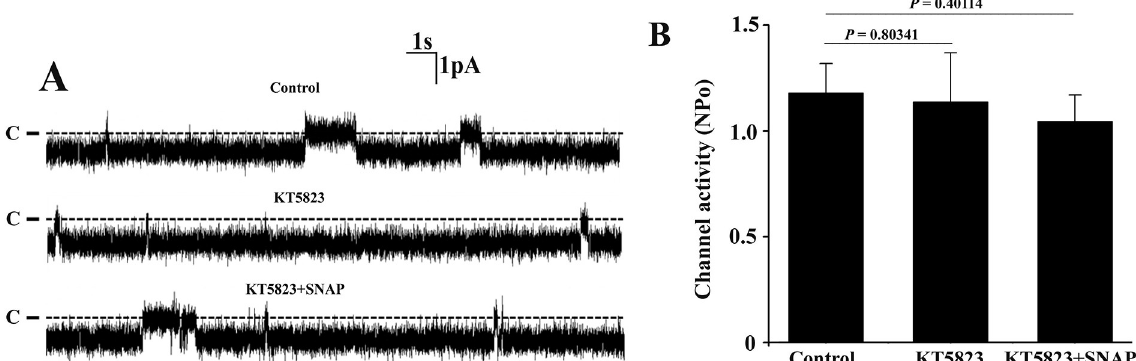
Fig 5. Inhibition of PKG abolishes the effect of SNAP on the 10-pS Cl - channels in the TAL. (A) Representative single channel recordings from the same cell-attached patch under control condition, in the presence of 10 μ M KT5823 alone as well as in the presence of both KT5823 (10 μ M) and SNAP (5 μ M). The holding potential was -60 mV and the channel closed level is indicated by the dotted line and “C”. (B) The bar graph showing that KT5823 eliminates the inhibitory effect of SNAP on the channel.